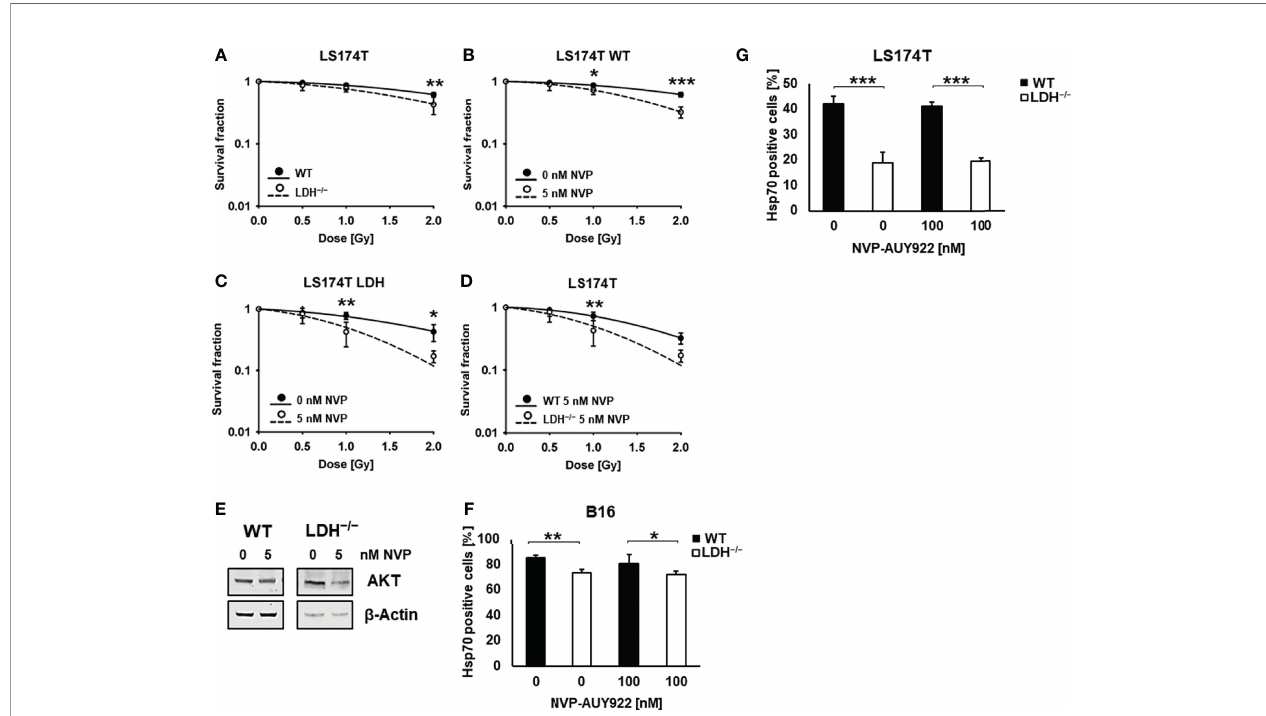
FIGURE 2 | Hsp90 inhibition potentiates radiosensitivity in LS174T cells. (A) Colony forming assay of LS174T WT and LDH − / − cells after irradiation with 0, 0.5, 1 and 2 Gy (**p ≤ 0.01). Colony forming assay of LS174T WT (B) and LDH − / − (C) cells after treatment with a low concentration of NVP-AUY922 (5 nM) for 24 h and irradiation with 0, 0.5, 1 and 2 Gy (*p ≤ 0.05, **p ≤ 0.01, ***p ≤ 0.001). (D) Comparison of WT and LDH − / − cells treated with a low dose of NVP-AUY922 (5 nM) (**p ≤ 0.01). (E) Representative immunoblot showing the expression of AKT and b -Actin in LS174T cells upon treatment with NVP-AUY922 (5 nM) for 24 h. (F, G)